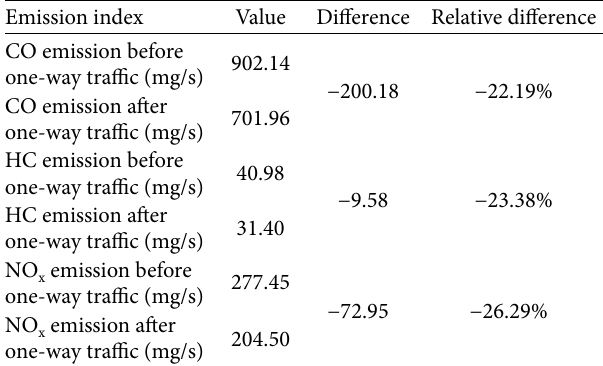
Table 7: Emissions in the road sections before and after one-way traffic management.